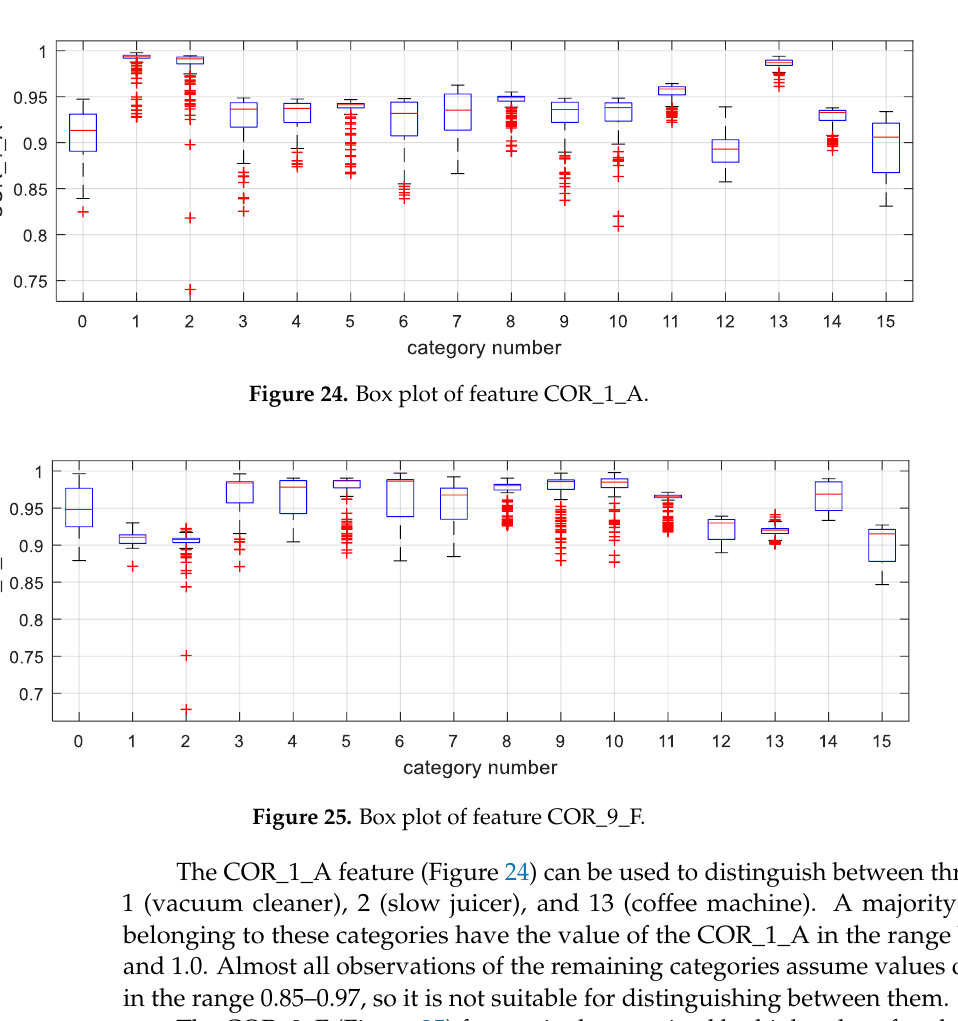
Figure 24. Box plot of feature COR_1_A.